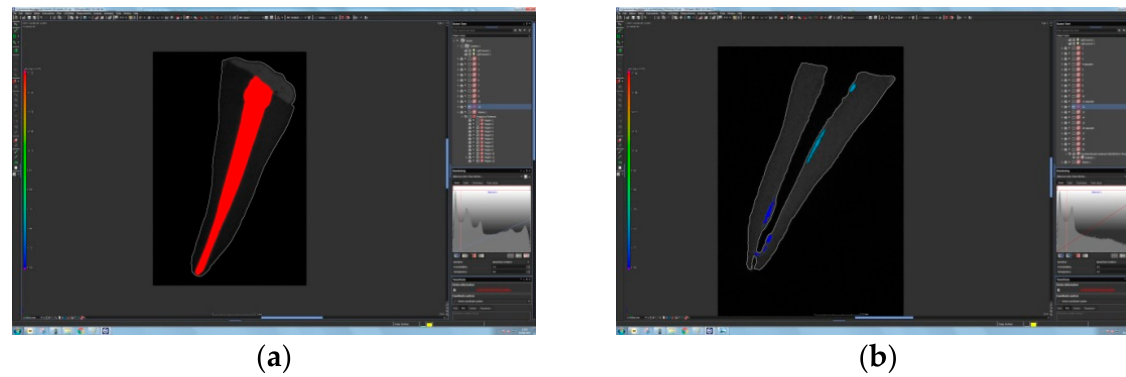
Figure 1. Cross-sectional micro-CT images of tooth specimens: ( a ) tooth specimen obturated with bioceramic sealer in combination with bioceramic gutta-percha; ( b ) same specimen after retreatment using Reciproc R25.